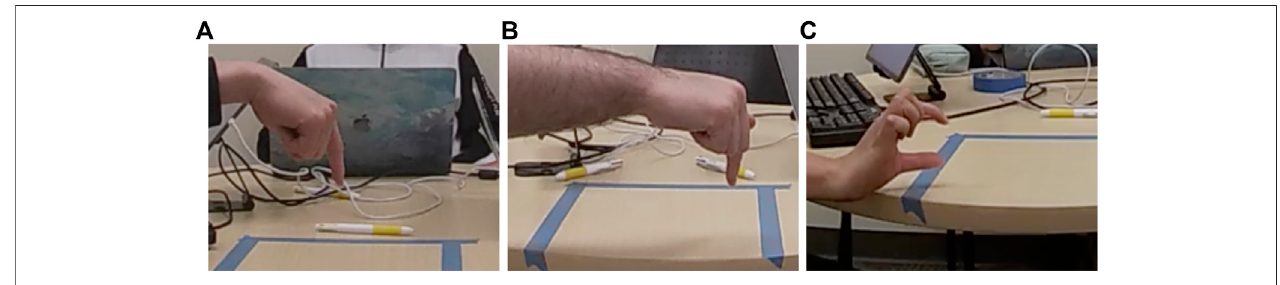
FIGURE 9 | (Strategy I) pointing straight down from the top (A) , (Strategy II) penetrating into the virtual cube (B) , (Other) grabbing a virtual cube (C) .